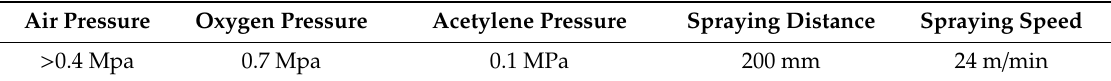
Table 2. The main process parameters of flame